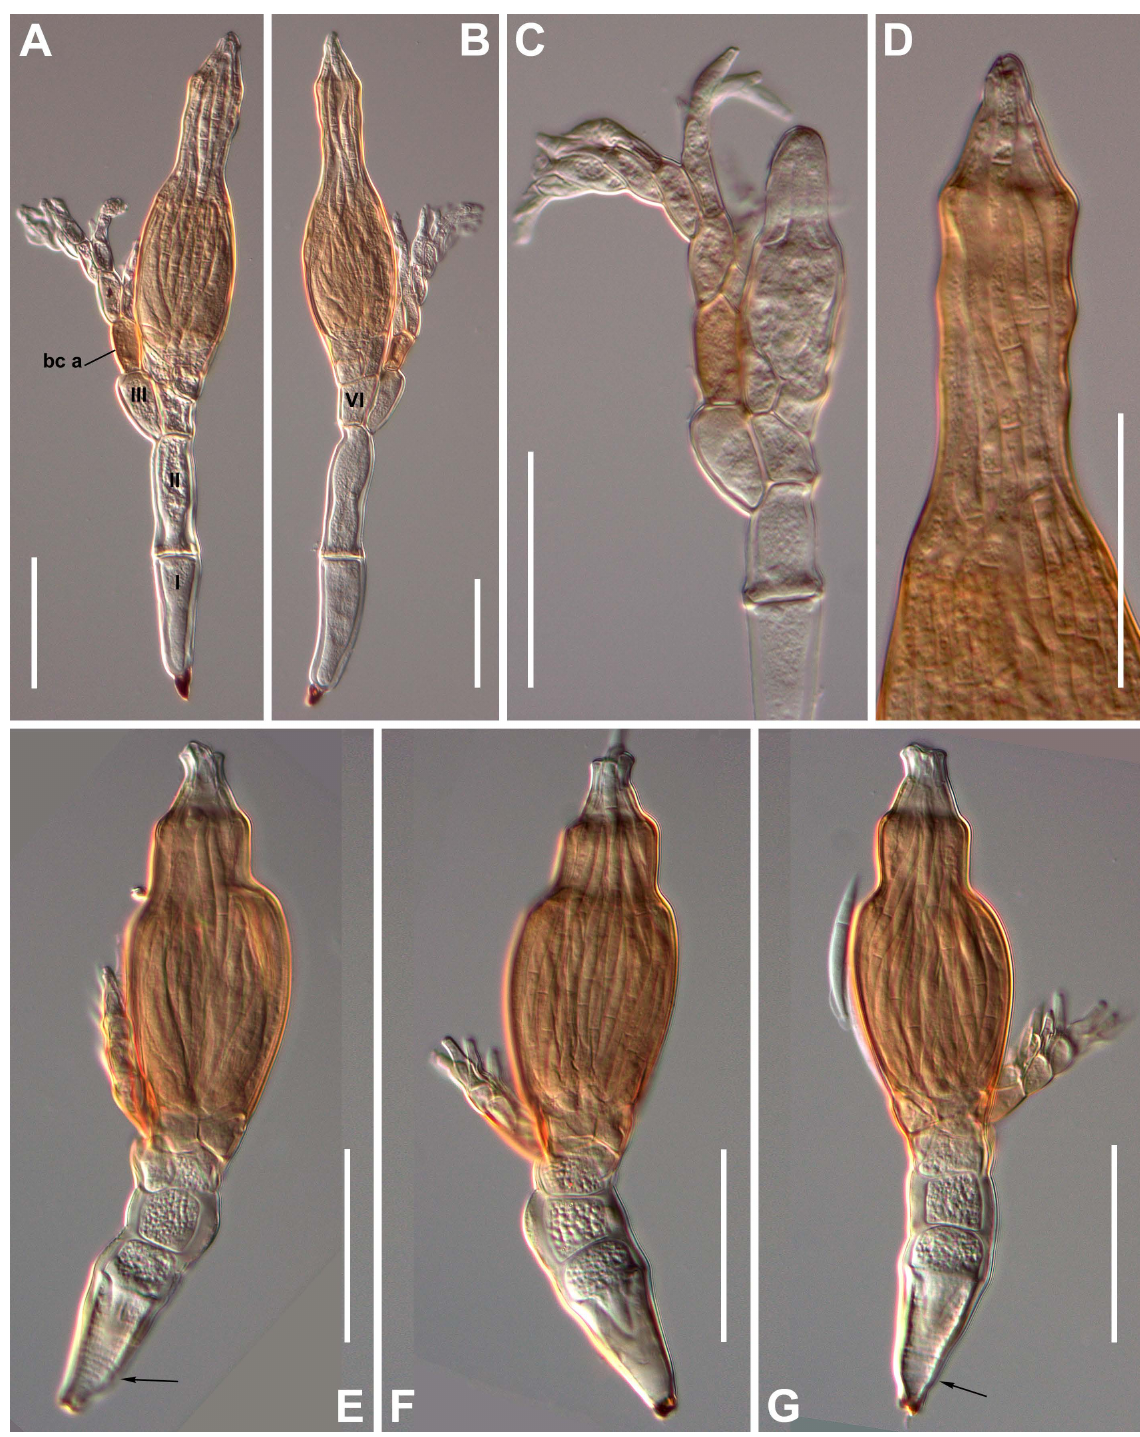
Fig. 56. Stigmatomyces spp. A – D . S. burdigalensis (Balazuc) A.Weir & W.Rossi. A – B . Mature thalli showing labelled cells I, II, III, VI, and basal cell of primary appendage (bc a). C . Primary appendage in detail from an immature thallus. D . Perithecial apex in detail showing slightly undulate margins and a conical tip. – E – G . S. constrictus Thaxt. Mature thalli. Surface of basal cell I appears characteristically striated (arrows in E and G). Scale bars: 50 µm. Photographs from slides ZMUC C-F-123707 (A–D), ZMUC C-F-124084 254